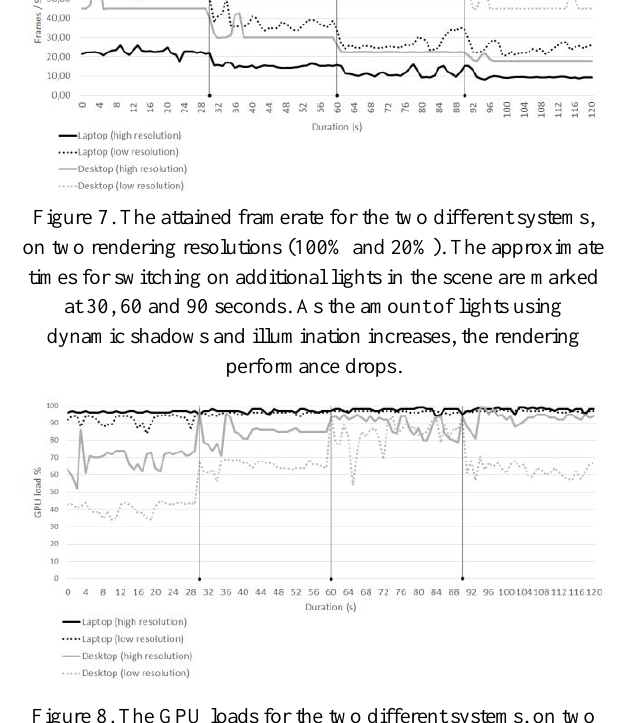
Figure 8. The GPU loads for the two different systems, on two rendering resolutions (100% and 20%). The approximate times for switching on additional lights in the scene are marked at 30, 60 and 90